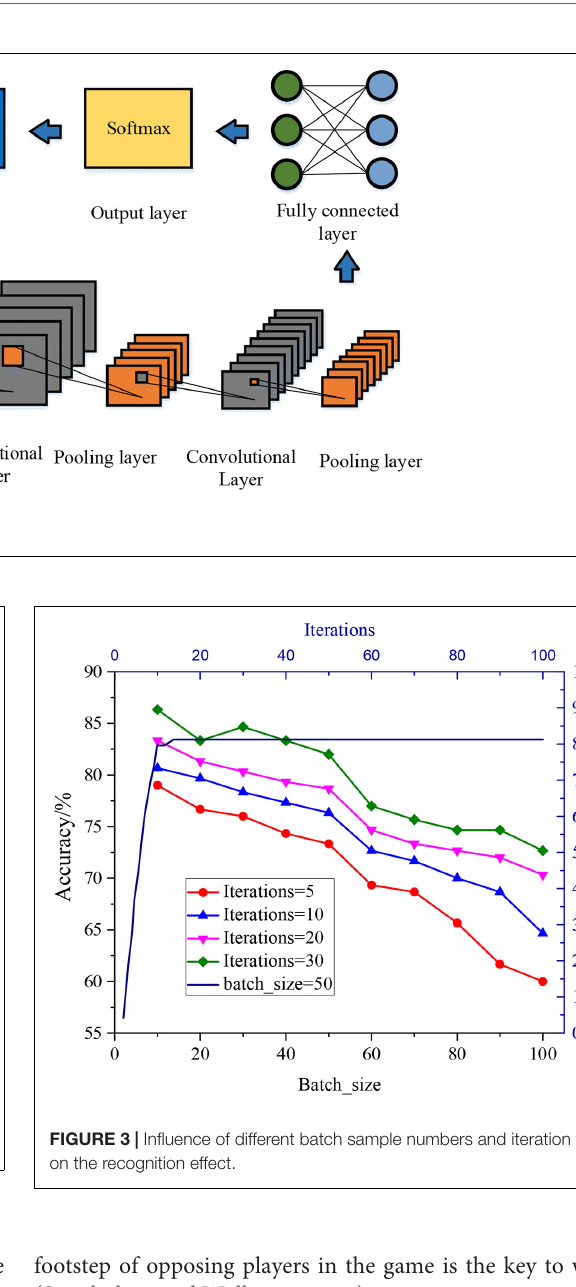
footstep of opposing players in the game is the key to winning (Stambulova and Wylleman,